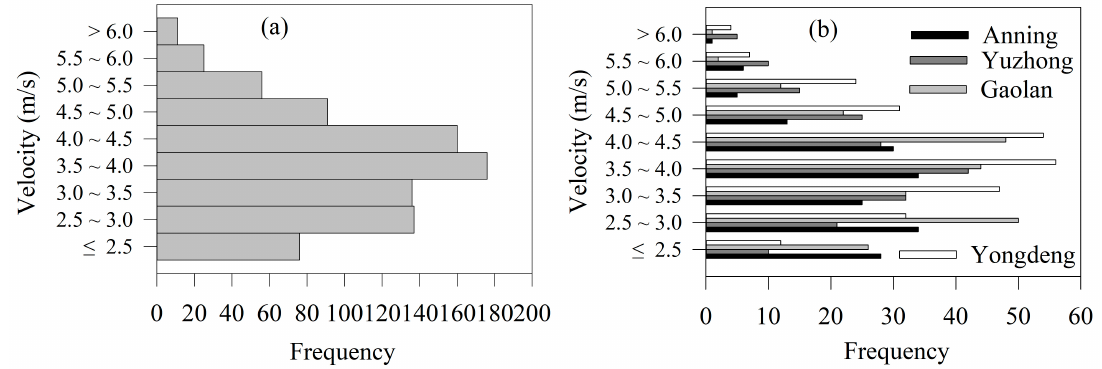
Figure 3. Frequency of precipitation events for different terminal velocities: ( a ) Lanzhou and ( b ) four sampling sites.